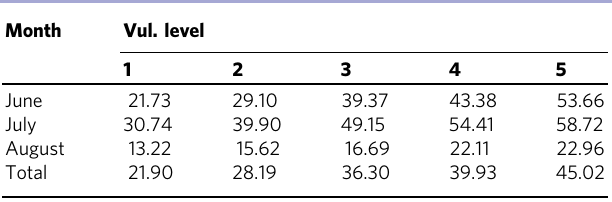
Vul. level stands for vulnerability